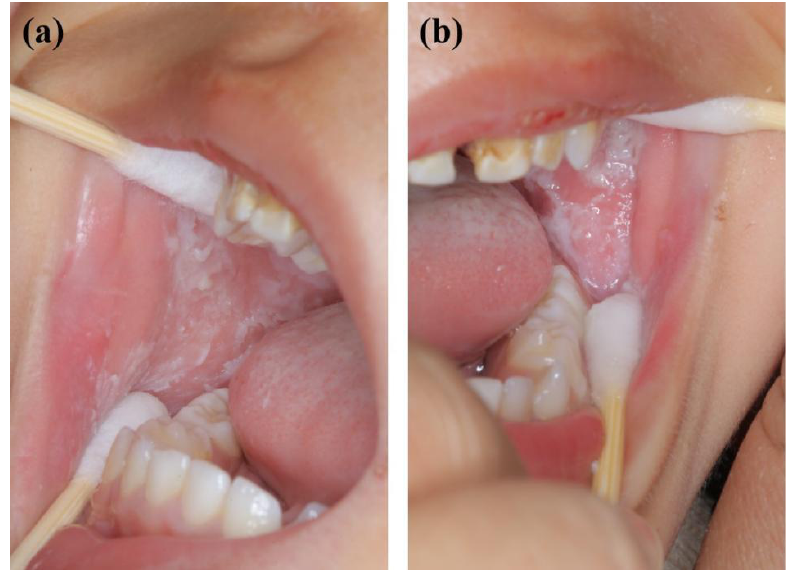
Figure 1. Oral manifestations of the proband (the 2-year-old boy) showing large gray and white folds and plaques in the ( a ) right and ( b ) left buccal mucosa.